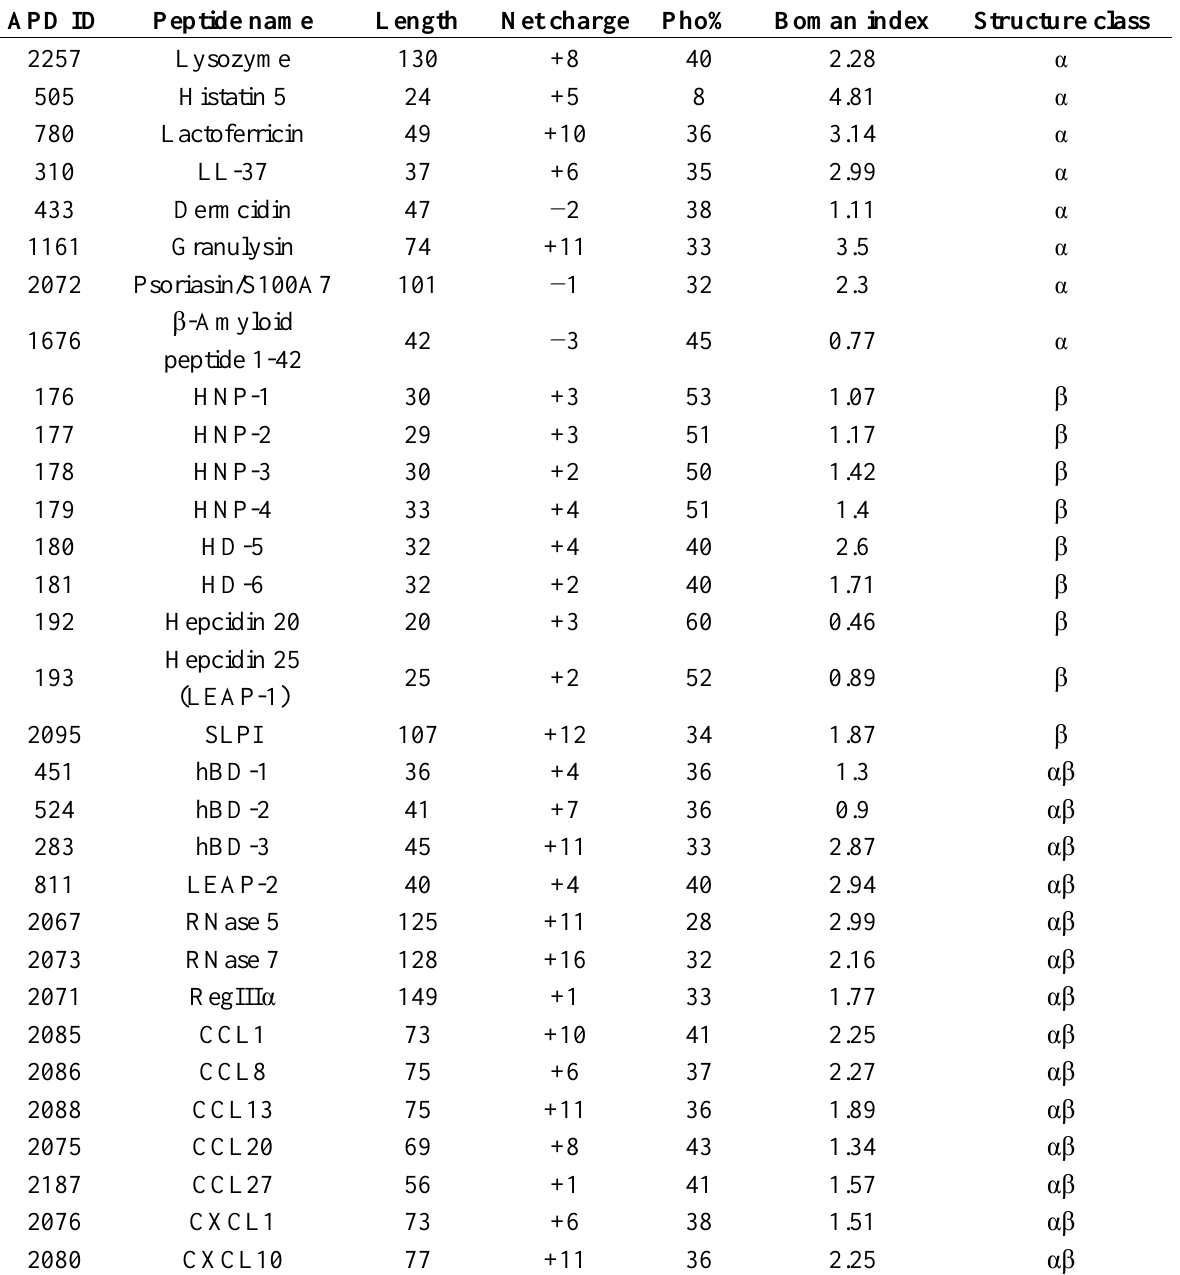
Table 2. Properties of selected human antimicrobial peptides with known 3D structure 1 . APD